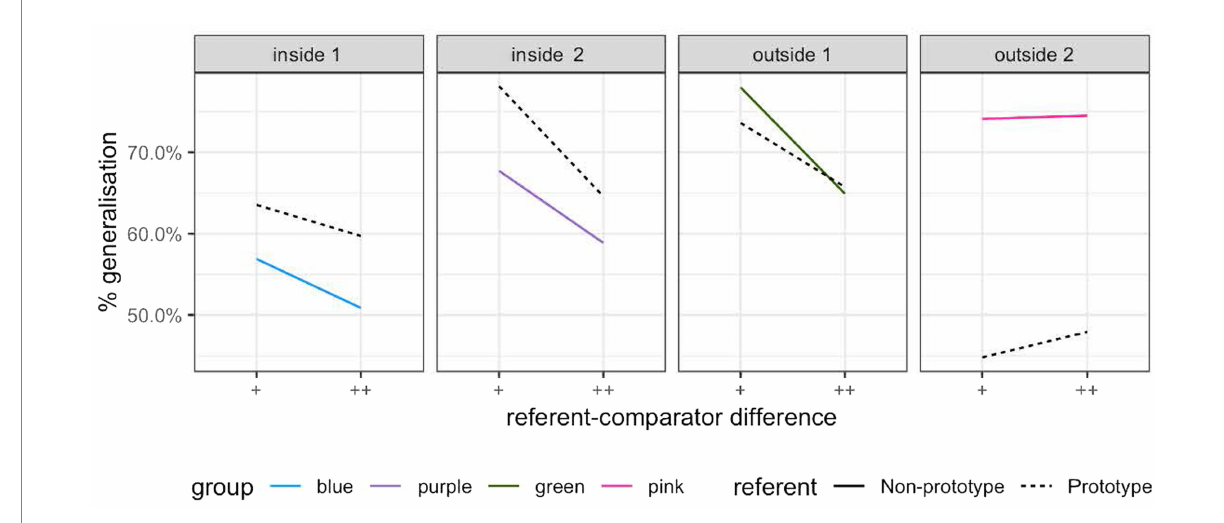
FIGURE 7 Generalization (misses) in the prototype (dashed) and non-prototype (solid) conditions in Experiment